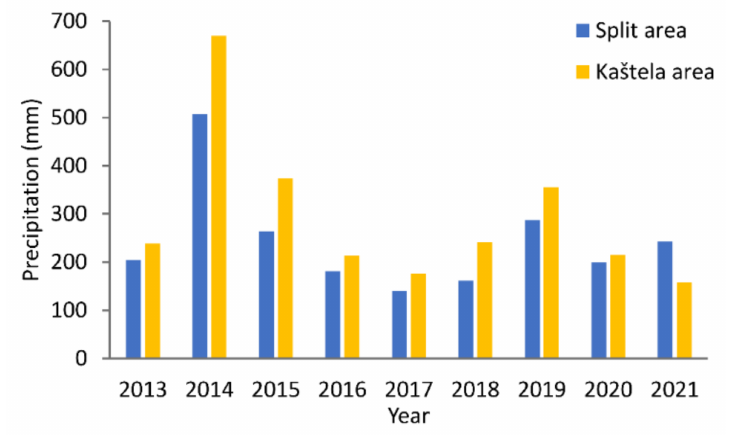
Figure 2. Total precipitation in the bathing season in the period 2013–2021. was found between precipitation and FIB values recorded a day after the rain (Table 2).